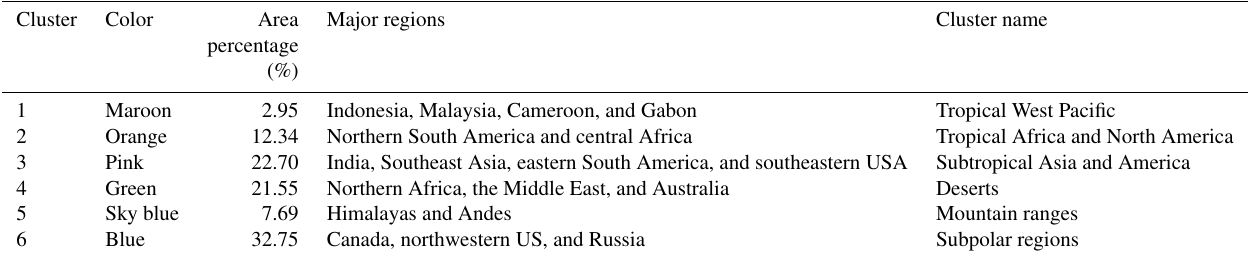
Table 2. Percentage area and major regions belonging to each cluster. Clusters are identified only for the global land areas. Cluster Color